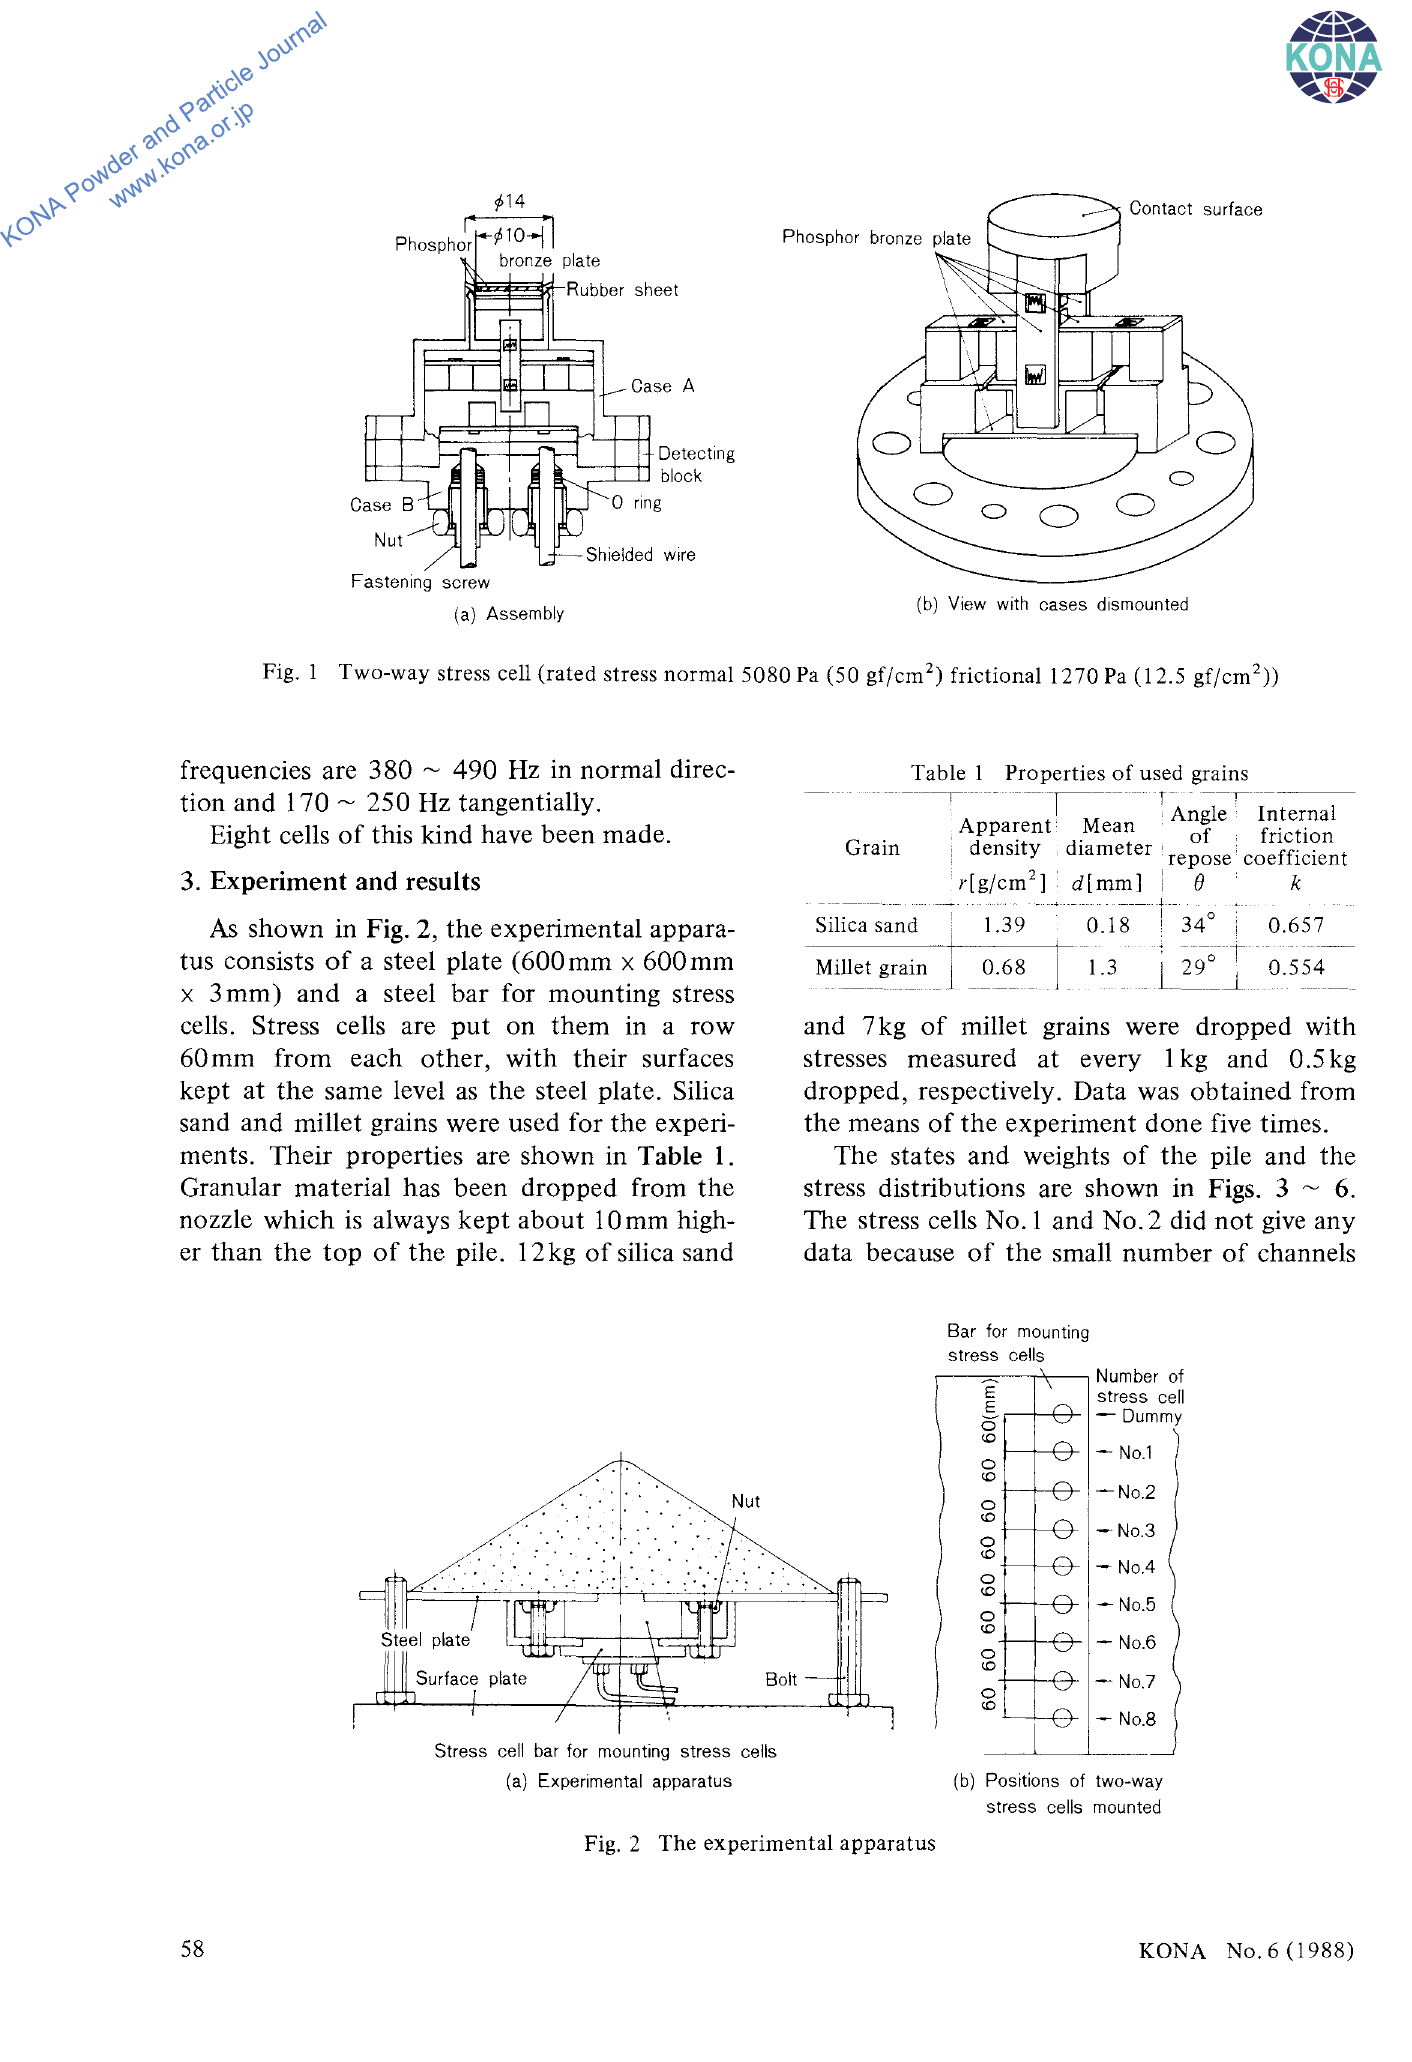
Fig. 2 The experimental